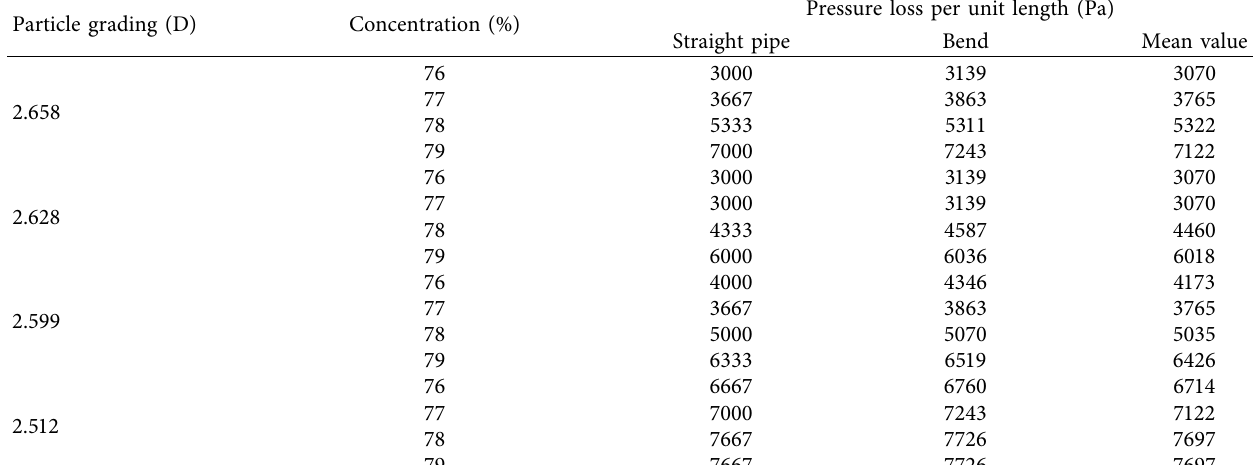
Table 7: Summary of pressure loss per unit length of slurry with different proportions.